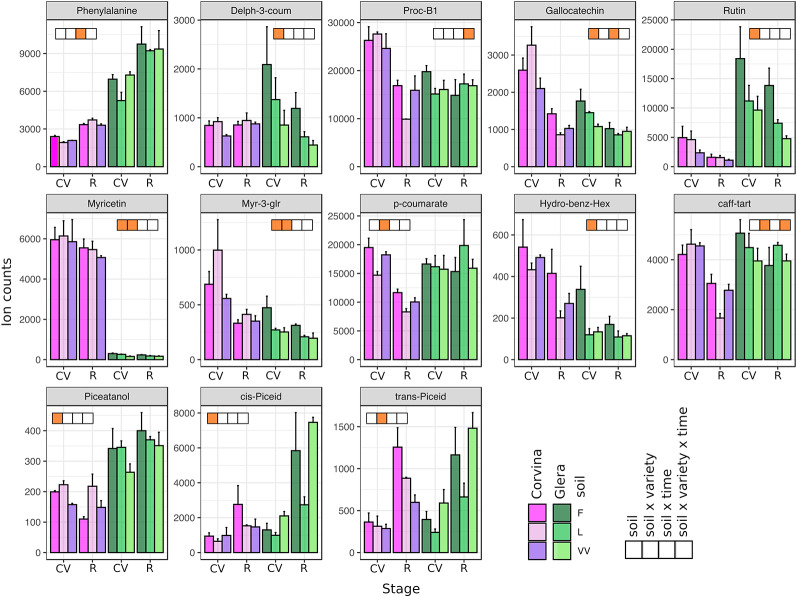
Secondary metabolites detected by LC-MS in berry skin tissues in response to different soils. Included are metabolites found to be significantly affected by the soil factor and its interactions with other factors (variety and phenological stage) based on multifactorial ANOVA. Levels represent relative abundance based on ion counts. Purple bars represent the Corvina variety and green bars represent the Glera variety. Different color intensities indicate different soils, whereas orange squares indicate the statistical significance related to soil factor and/or its interactions with the other factors. CV and R stand for complete véraison and ripening, respectively. Error bars indicate standard error (n = 3).